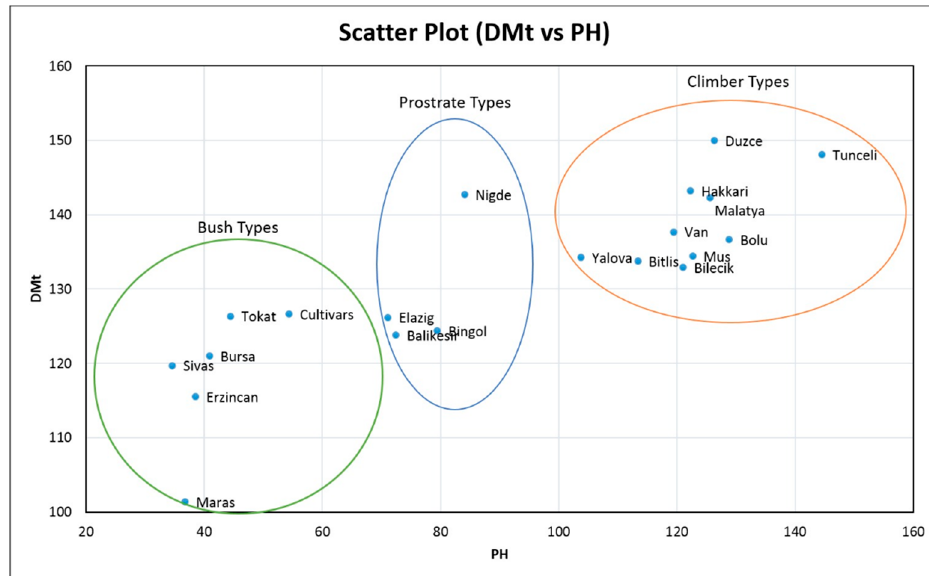
Figure 2. Scatter plot plant height and days to maturity diversity in Turkish common bean germplasm for various Turkish provinces.